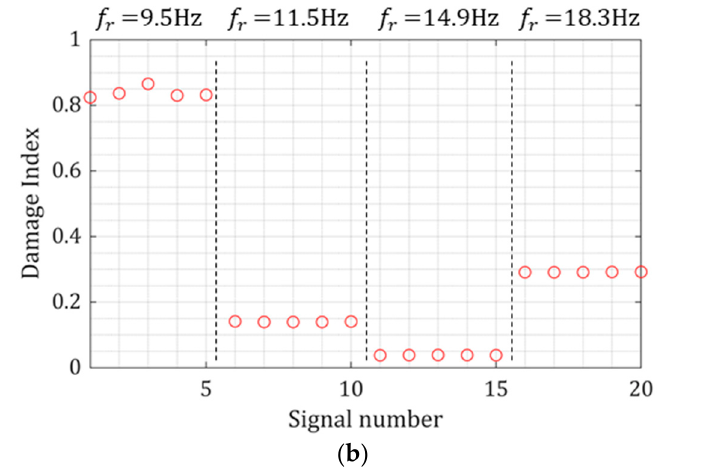
Figure 19. ( a ) Statistical features from the piezoelectric outputs at the defect-free and fault states, and ( b ) the damage index for the fault signals.